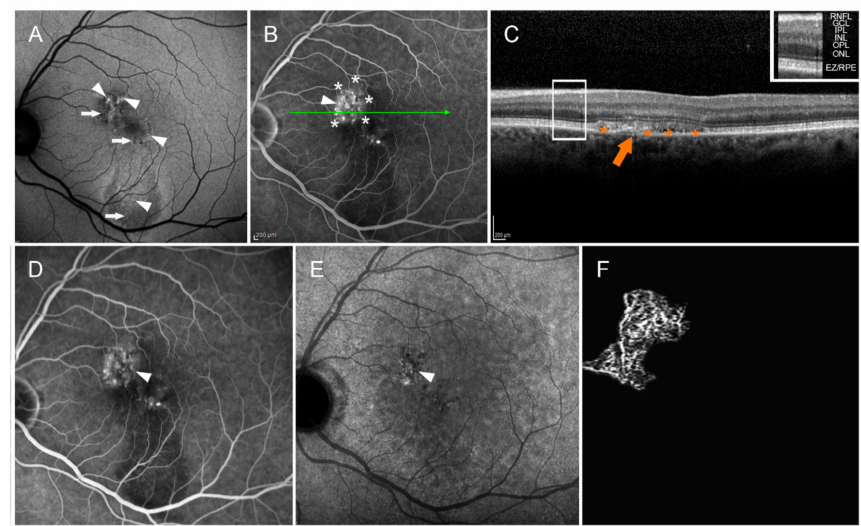
Figure 5. Central serous chorioretinopathy complicated by type 1 macular neovascularization. BAF ( A ) image shows the presence of macular hypoautofluorescent (white arrows) and hyperautofluo- rescent (white arrowheads) alterations, with a sparing of the foveal region and not homogeneous autofluorescence in the inferior part of the posterior pole, interpreted as a gravitational disposition of fluid. FA ( B ) reveals the presence of a hyperfluorescent alteration (white arrowhead) with perilesional leakage (white asterisks), which corresponds to a sub-RPE hyperreflective lesion (orange arrow) with subretinal fluid and shram (orange asterisks) ( C ). The OCT layers legend is provided in the upper-right part of the image. The hyperfluorescent lesion on FA (white arrowhead) ( D ) results mainly hypocyanescent on ICGA (white arrowhead) ( E ). OCTA well reconstructed the sub-RPE neovascular network ( F ). The following abbreviations are used: retinal nerve fiber layer (RNFL), ganglion cell layer (GCL), inner plexiform layer (IPL), inner nuclear layer (INL), outer plexiform layer (OPL), outer nuclear layer (ONL), ellipsoid zone/retinal pigment epithelium complex